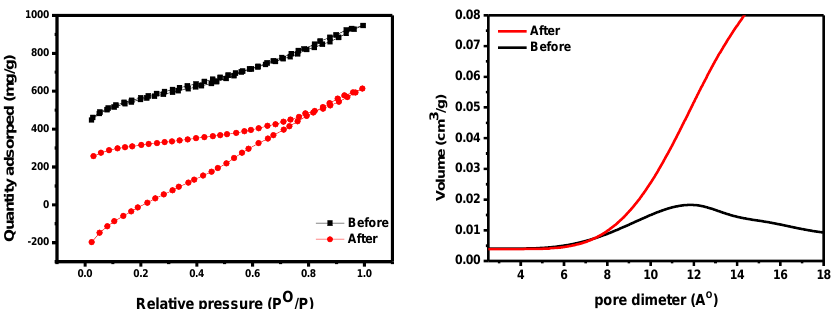
Figure 6. The BET data of GO − date ( left panel ). The pore size distribution of GO − date before and after adsorption ( right panel ).